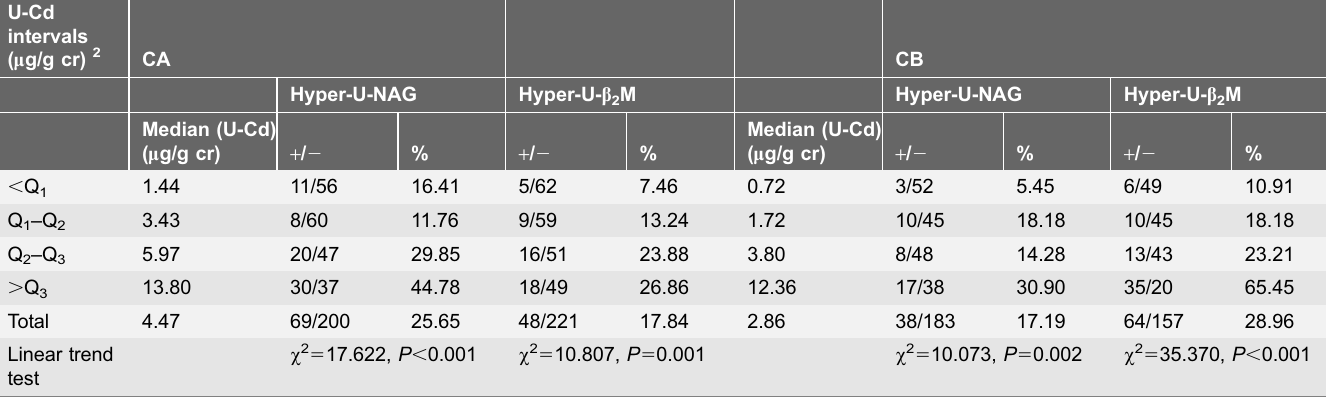
Table 5. Prevalence of hyper-U- b 2 M and hyper-U-NAG corresponding to U-Cd intervals among subjects in county A (CA) and county B (CB) at different cadmium exposure levels 1 . U-Cd intervals